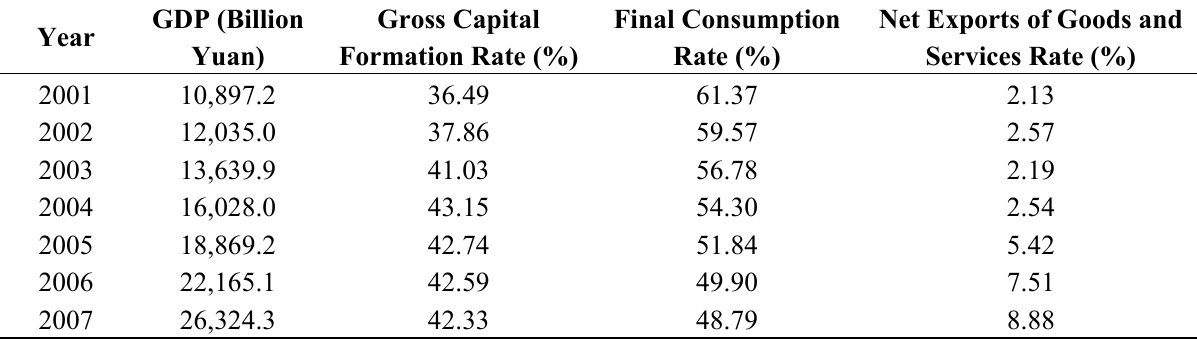
Table 5. Gross domestic product (GDP) by expenditure